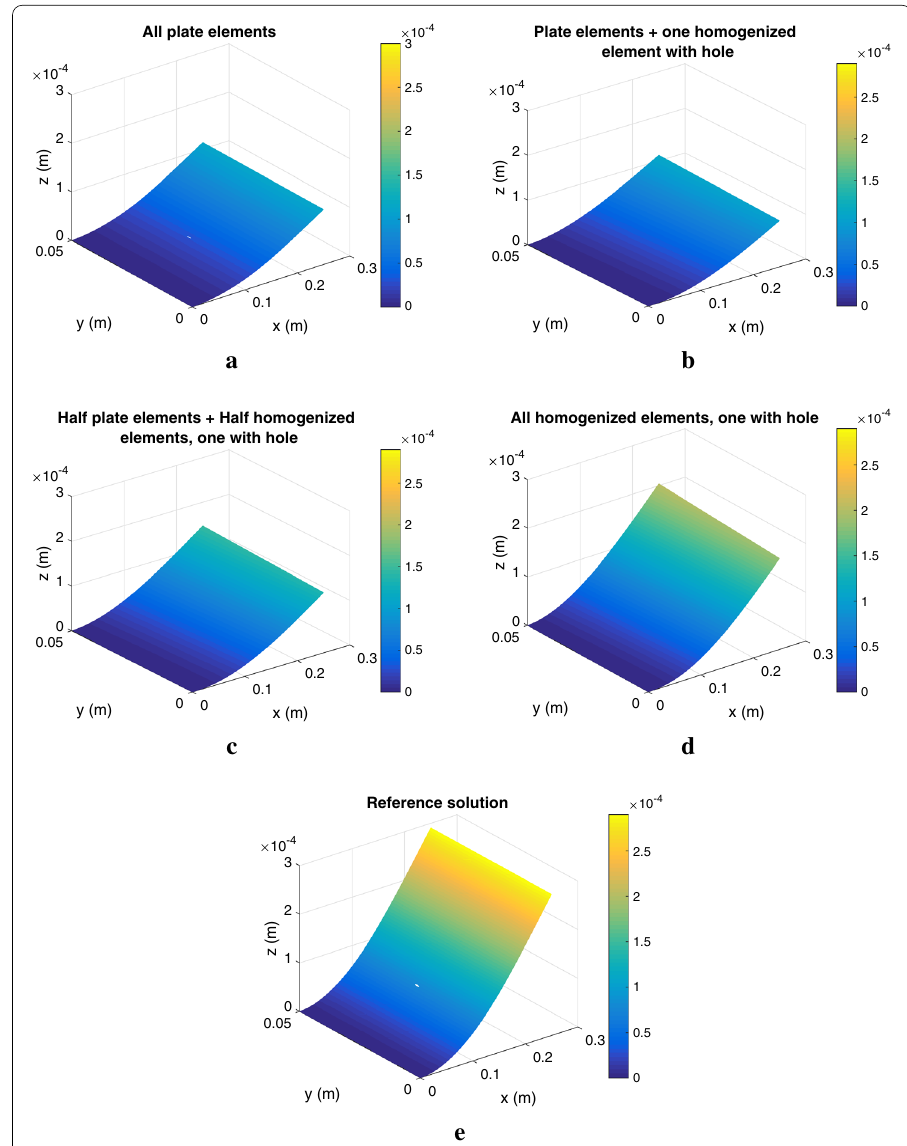
Fig. 8 Displacement of the plate middle plane using plate theory ( a ), all plate theory elements except the homogenized (enriched) holed element ( b ), half plates theory elements (the triangles of the mesh in Fig. 2 with the right angle on the bottom) and half homogenized elements (the triangles of the mesh in Fig. 2 with the right angle on the top), one of them holed ( c ), all homogenized elements, one of them holed ( d ), fully 3D theory on the fine mesh ( e